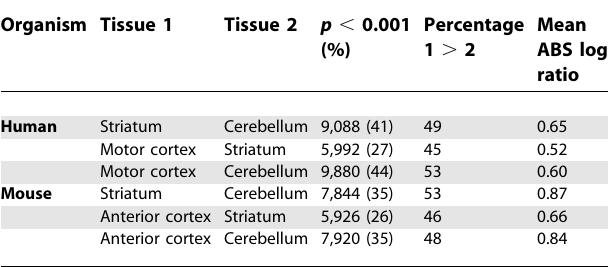
Table 1. Different Regions of the Brain Show Many Statistically Significant Differentially Expressed Genes Organism Tissue 1